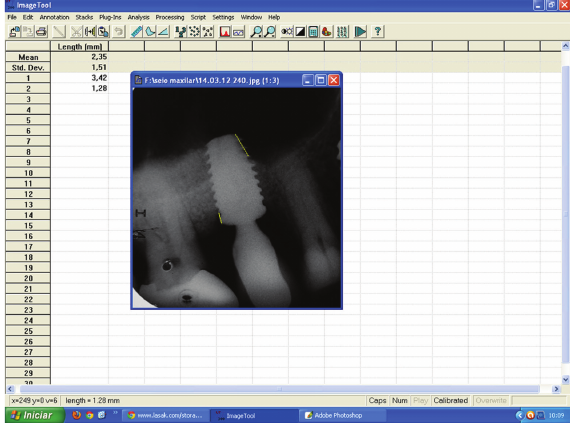
Figure 5: Image of the measurements being made with the review program Image Tool 3.0 for Windows.